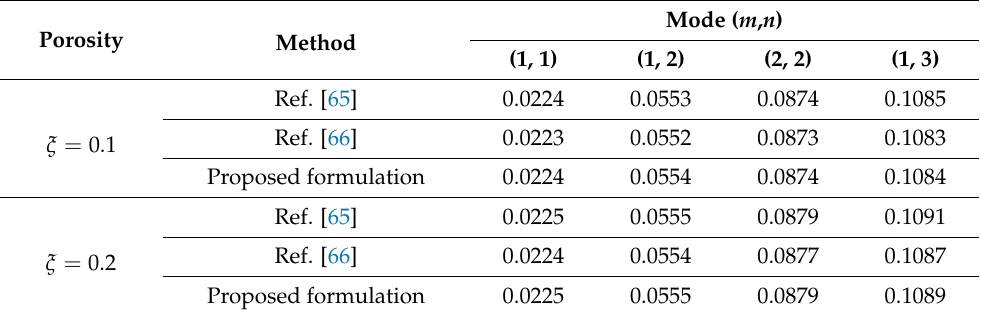
Table 3. Fundamental frequency ˆ ω for the SS FG square plate ( p = 1 and a / h = 20 ).